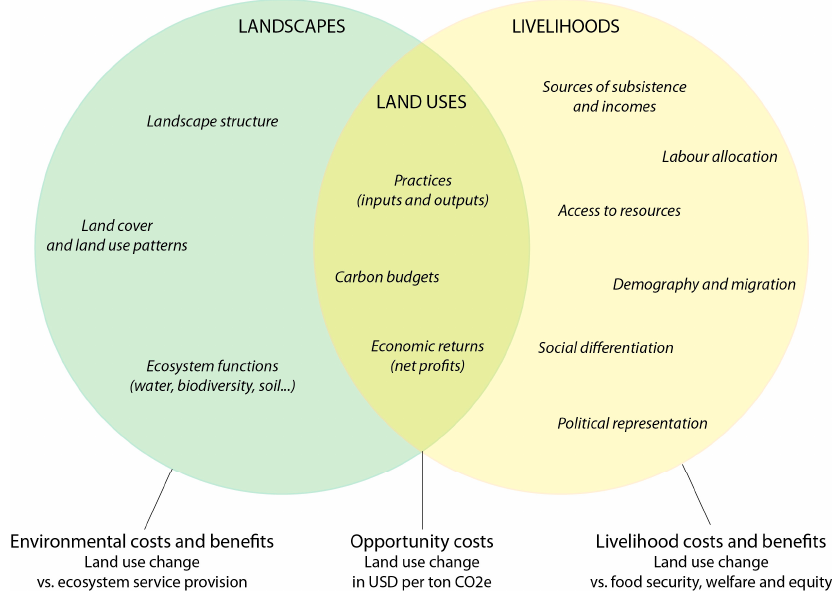
Figure 1. Nested approach to the opportunity costs of reducing emissions from deforestation and forest degradation and enhancement of forest carbon stocks (REDD+) transitions (the authors).